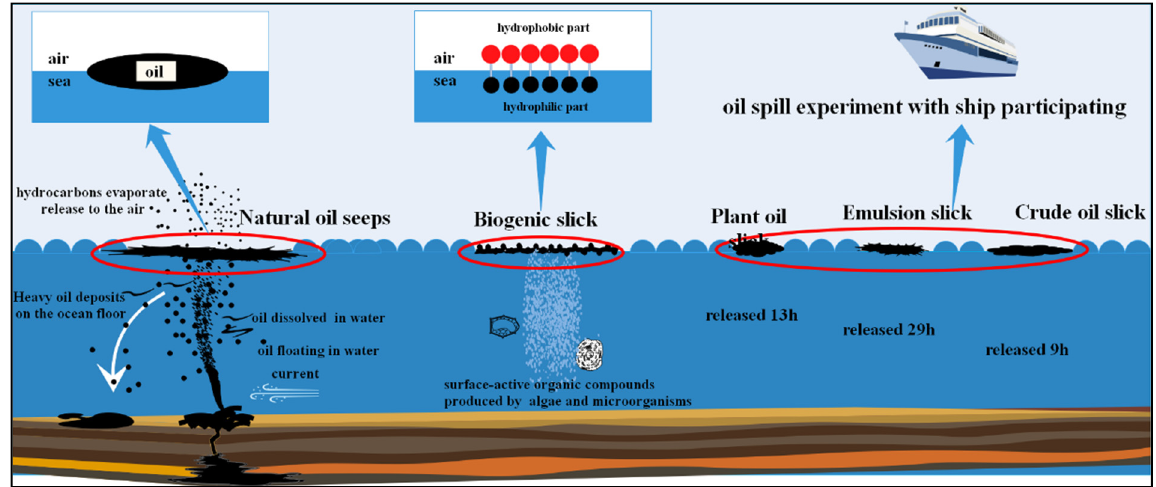
Figure 2. Schematic of different types of oil slicks formed in the marine environment.